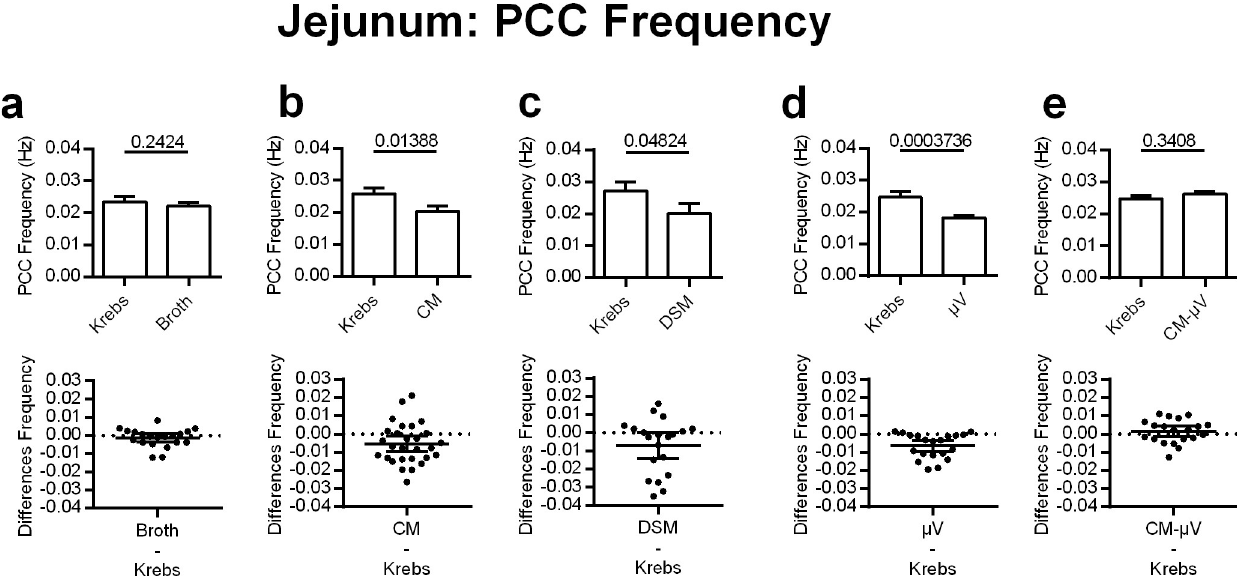
Fig 3. Effects of adding DSM, μ V or media on PCC frequency for mouse jejunal segments, in vitro . c) DSM (N = 20), b) CM (N = 28) and d) μ V (N = 20) decreased PCC frequency. a) Broth (N = 20) or e) CM- μ V (N = 20) had no statistically significant effects on PCC frequency. P values derived from paired t-tests are given above horizontal bars. Significance determined when p <